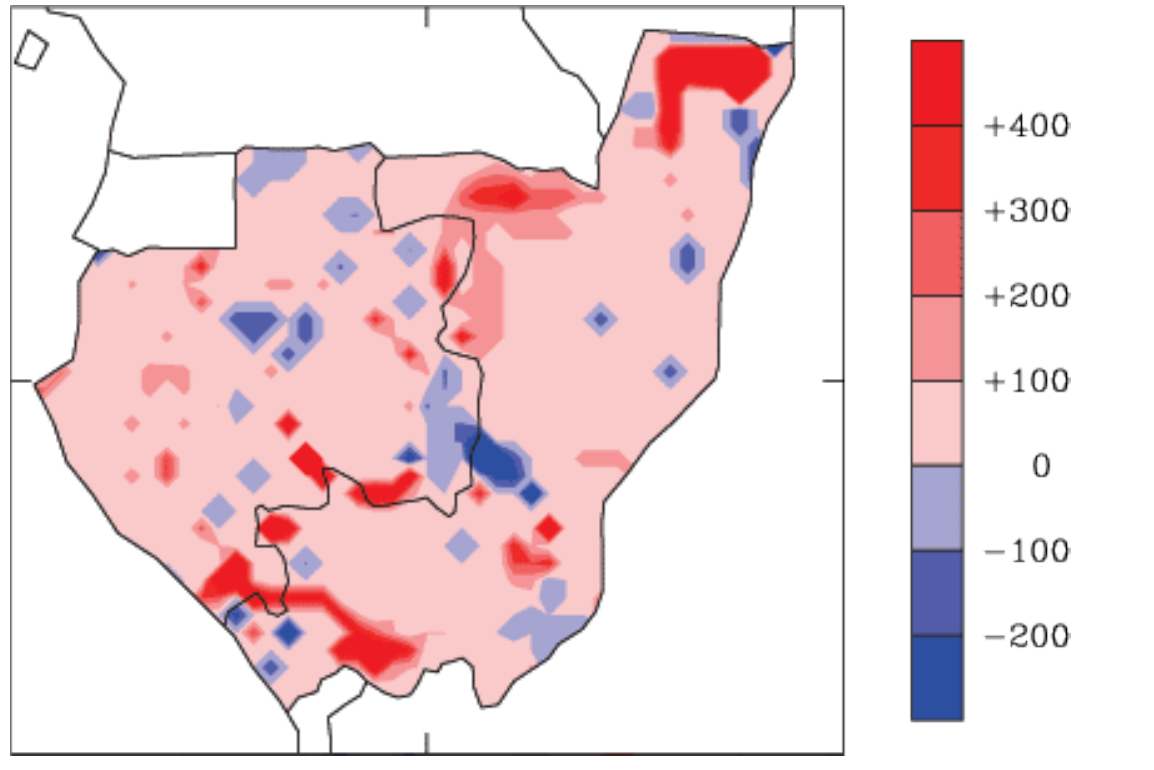
Fig. 6 . Simulated monthly averaged cloud-base-height differences (m) between control and deforestation scenarios for October 2001 in Gabon and the Republic of